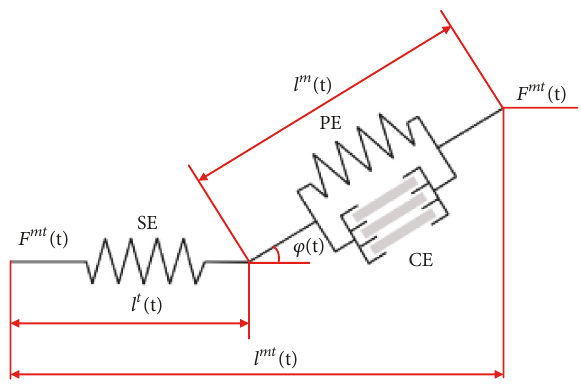
Figure 3: The Hill-type muscle model